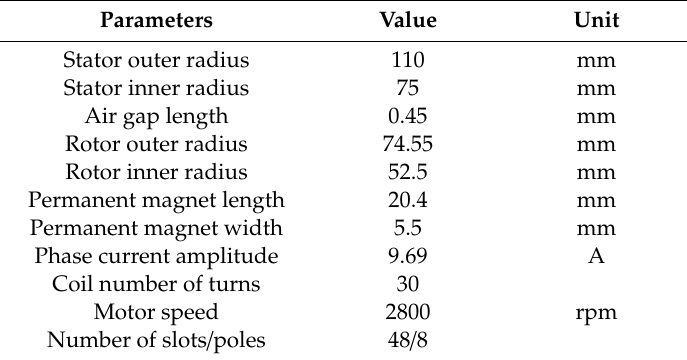
Table 1. IPM fixed parameter